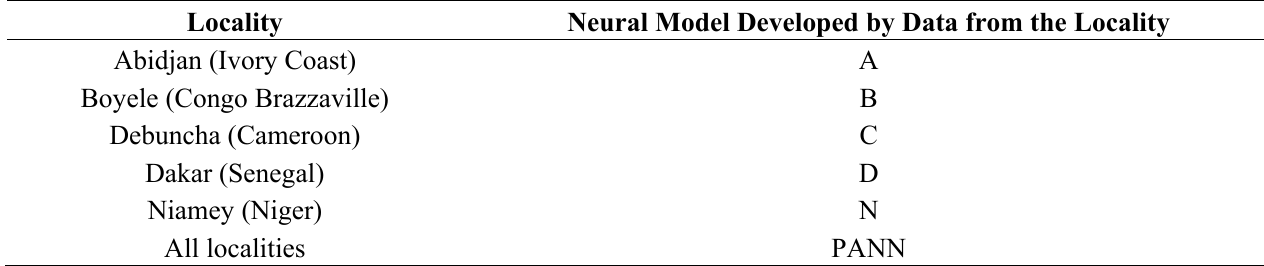
Table 3. Model designation for each